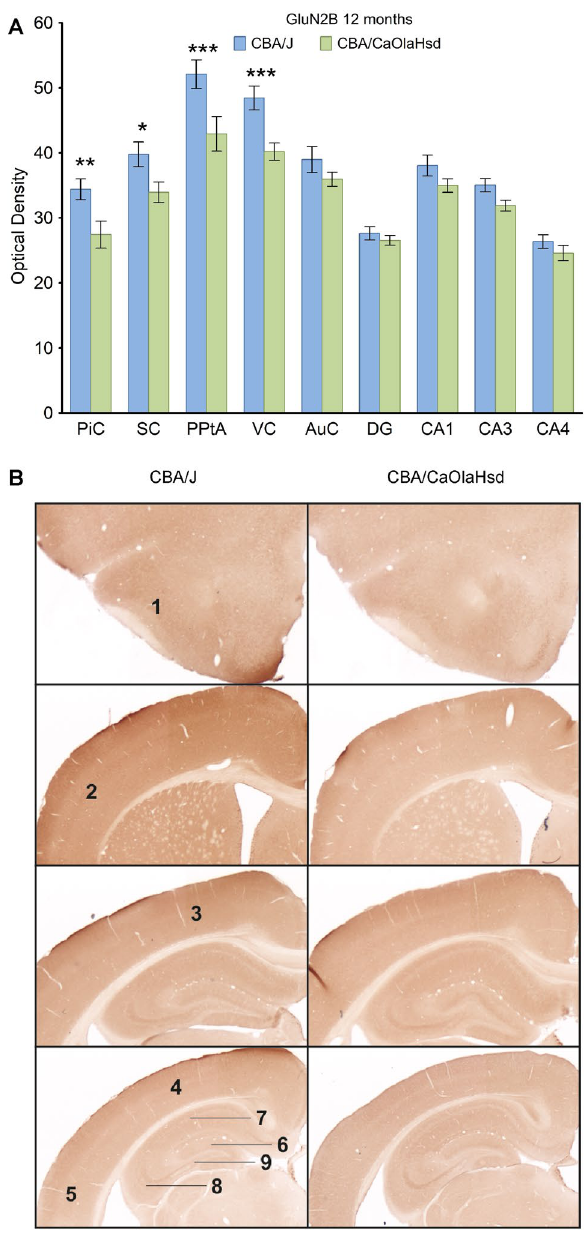
Figure 4. GluN2B expression is partially increased in blind mice 12 months postnatally compared to CBA/ CaOlaHsd mice. ( A ) Bar charts represent mean GluN2B subunit optical densities in different brain regions 12 months postnatally in CBA/J (blind) mice compared to CBA/CaOlaHsd mice. Subunit density is significantly increased only in the piriform cortex (PiC), somatosensory cortex (SC), posterior parietal cortex (PPtA) and visual cortex (VC) in CBA/J mice. *P < 0.05; **P < 0.01; ***P < 0.001. ( B ) DAB-stained coronary sections showing GluN2B expression in CBA/J compared to CBA/CaOlaHsd mice 12 months postnatally. The photomicrographs highlight the changes as described in ( A ). 1: piriform cortex, 2: somatosensory cortex, 3: posterior parietal cortex, 4: visual cortex, 5: auditory cortex, 6: dentate gyrus, 7: CA1, 8: CA3, 9: